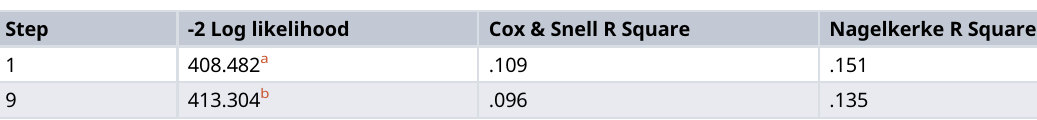
Table 1. Backward stepwise model